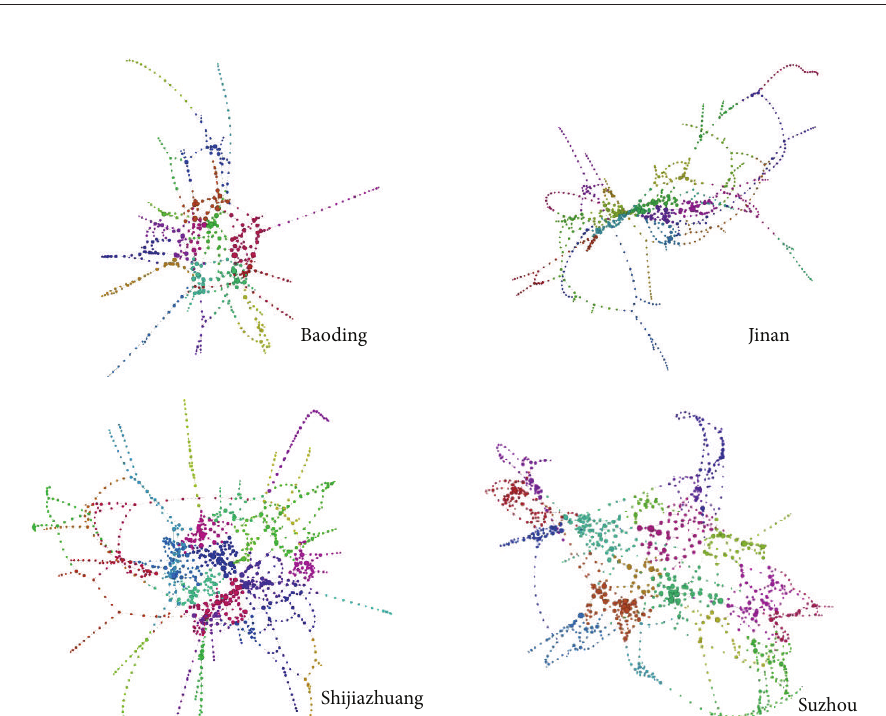
Figure 2: The topological structures of transit networks of Baoding, Jinan, Shijiazhuang, and Suzhou. The colors represent communities of transit network; the size of nodes represents the degree.